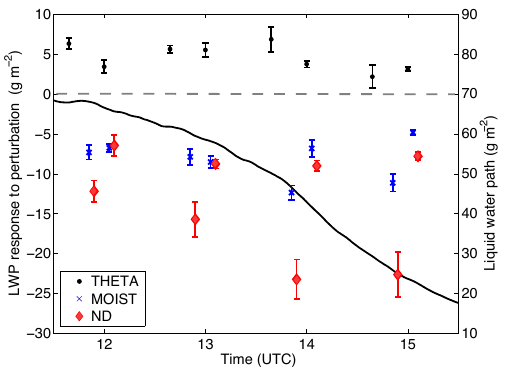
Fig. 10. Response of LWP to perturbations in meteorological con- text and aerosol state, computed from the experimental simulations (left y-axis). All mean responses are computed using 5-min tem- porally and domain averaged data, averaged over each of the four hours. Standard deviations for these means are shown with error bars. The grey dashed line indicates a zero response in LWP. The hour over which we average is the same for each computed re- sponse; we spread the responses out around each time for clarity. There are two computed hourly responses for each perturbation type; refer to Table 5 for exact expressions. For reference the black line shows the time series of base case LWP (right y-axis).